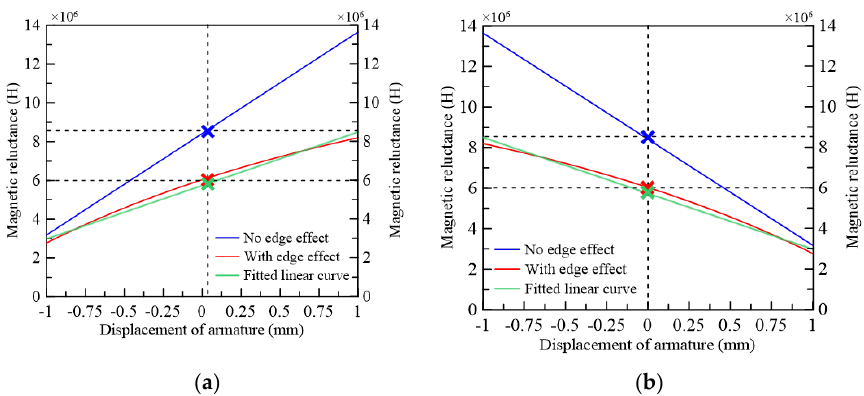
Figure 8. The variation of air gap magnetic reluctance with armature displacement. ( a ) R ag1 , R ag2 . ( b ) R ag3 , R ag4 . Table 2. The parameters used for the calculation of reluctance. Main Parameters